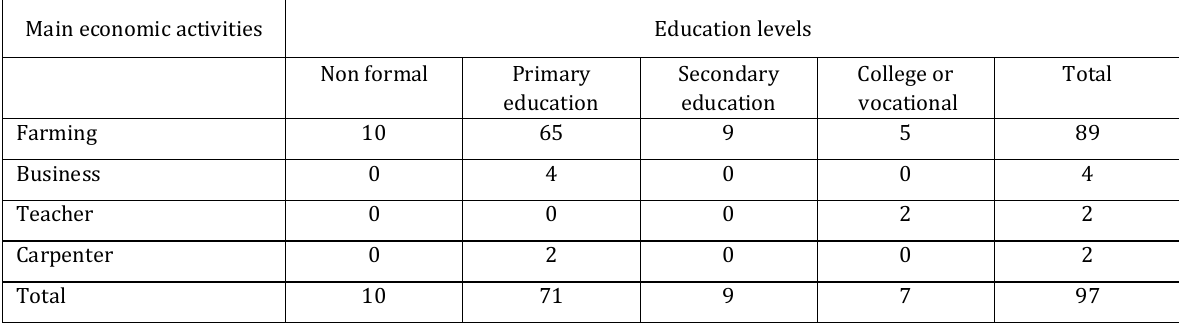
Table 2. Main economic activities of the respondents in relation to their education